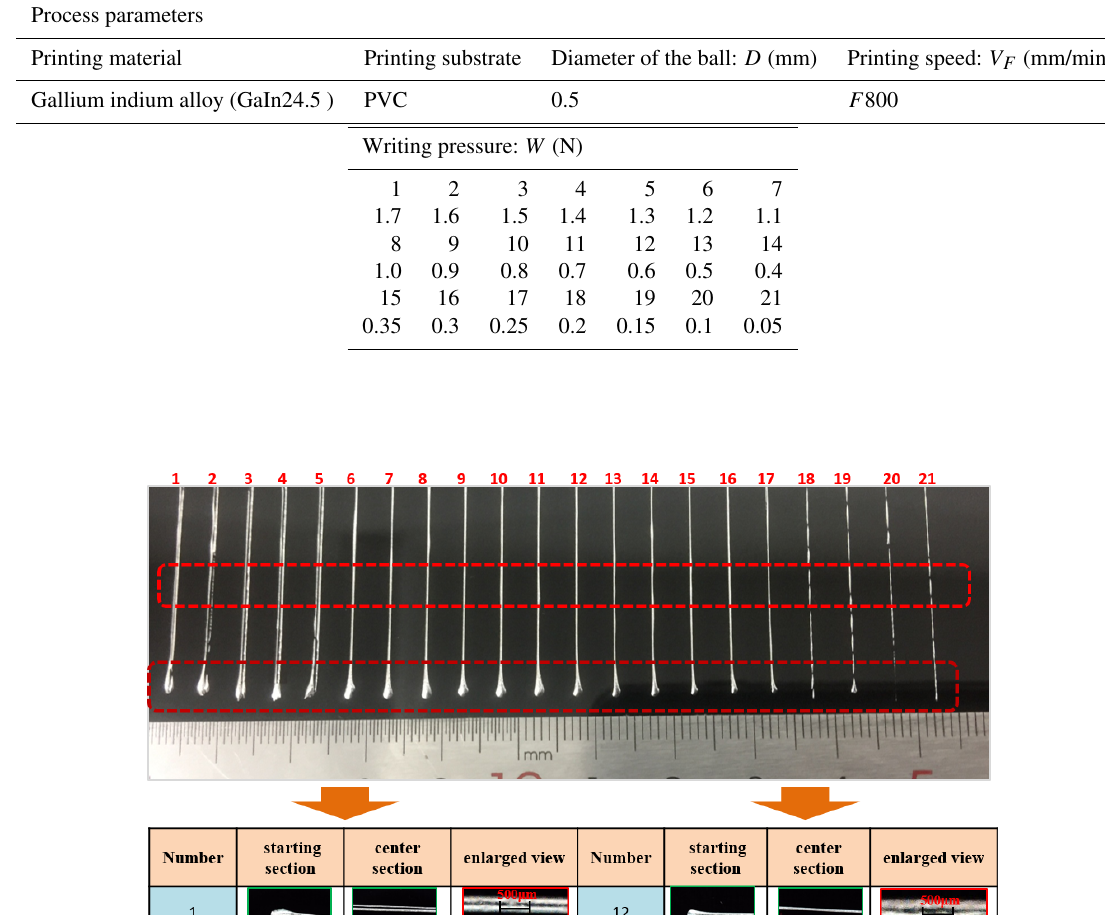
Table 2. Process parameters of direct-writing printing line.